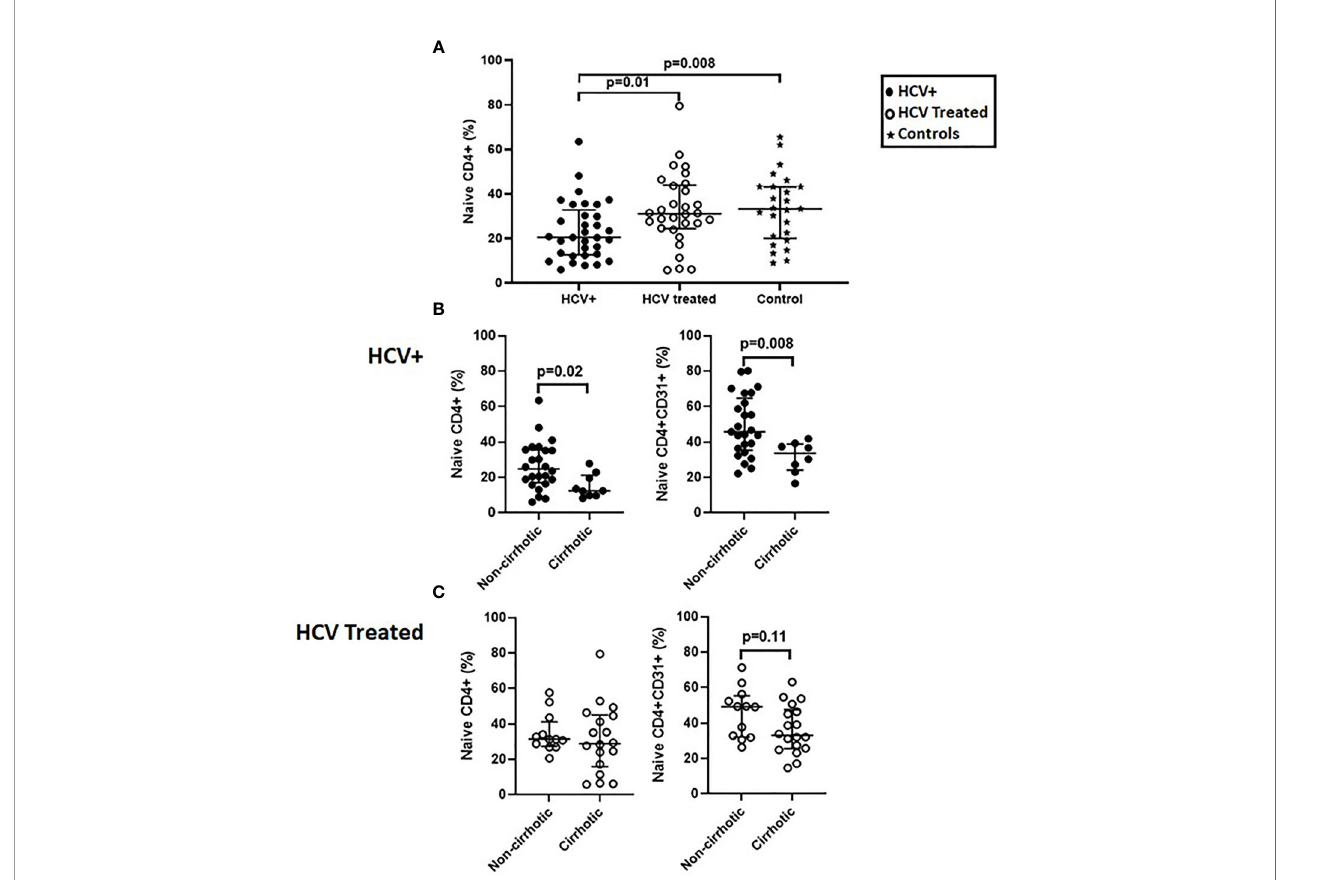
FIGURE 1 | Naïve CD4+ proportions are lower in HCV infected persons compared to direct-acting antiviral (DAA) -treated persons and age-range matched uninfected controls and the HCV infected persons with cirrhosis have lower naïve CD4+ and CD4+CD31+ proportions compared to those without cirrhosis before and after DAA therapy. In a cross-sectional cohort study; chronic HCV infected persons (n=34), HCV DAA-treated persons at 1-5 years post-DAA therapy initiation (n=29) and age-range matched uninfected controls (n=25) we compared proportions (%) of lymphocyte gated T cells that were naïve CD4 T cells (CD3+CD4+ CD27+CD45RA+) (A) . The HCV infected and DAA-treated groups were strati fi ed by cirrhosis status de fi ned by Transient Elastography scores with cirrhotics: >12.5 kilopaskals (kPa) and non-cirrhotics: <12.5 kPa. Proportions of naïve CD4+ and naïve CD4+CD31+ T cells were assessed (B, C) . Mann Whitney p values shown when